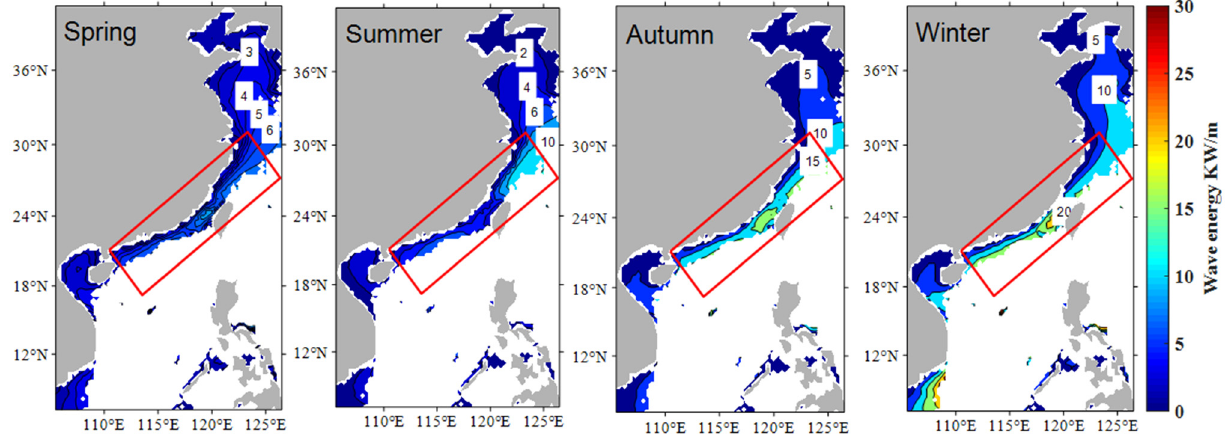
Figure 15. The distribution of seasonal mean P w in the selected area. According to ref. [40], for the Zhoushan Islands, it is suitable for the layout of the oscillating body (Sharp Eagle Wanshan) and overtopping (wave dragon) power genera- tion devices. For the middle sea of Zhejiang province, it is suitable for the layout of a mul- tipoint absorber (wave star) power generation device. For the Fujian area, it is more suit- able for multipoint absorber (wave star) power generation installation. For the surround- ing areas of Guangdong, an oscillating body (Sharp Eagle Wanshan) power generation device is suitable. The east sea of Hainan Island is suitable for oscillating body (Sharp Eagle Wanshan) and overtopping (wave dragon) power generation.